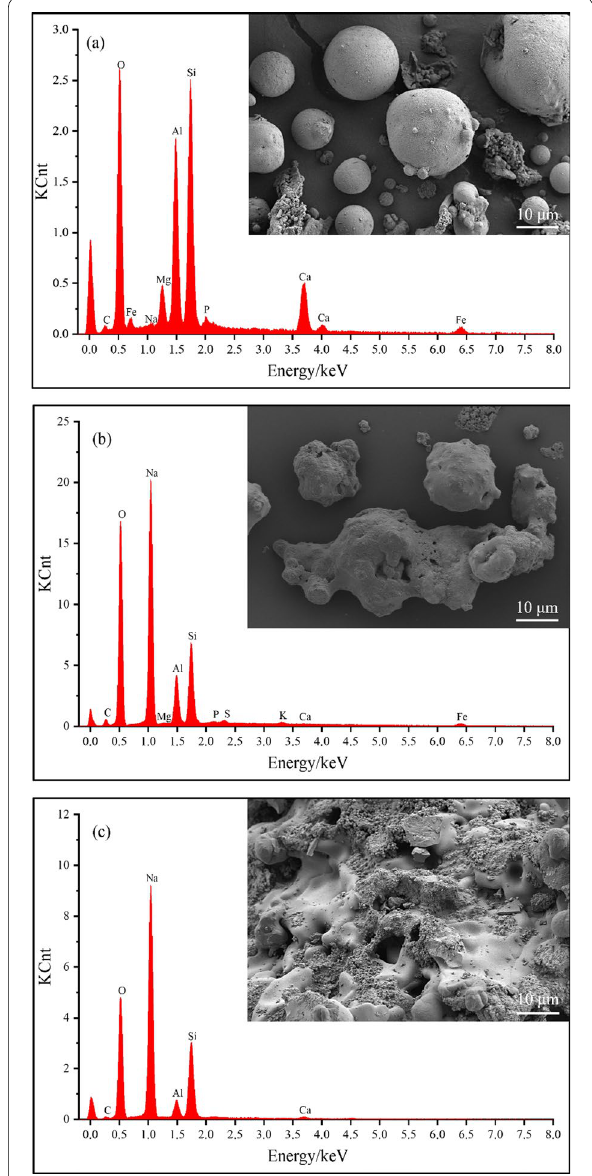
Fig. 1 Scanning electron microscopy and energy-dispersive X-ray spectroscopy characterization of a FA, b AFFA 200 , and c AFFA